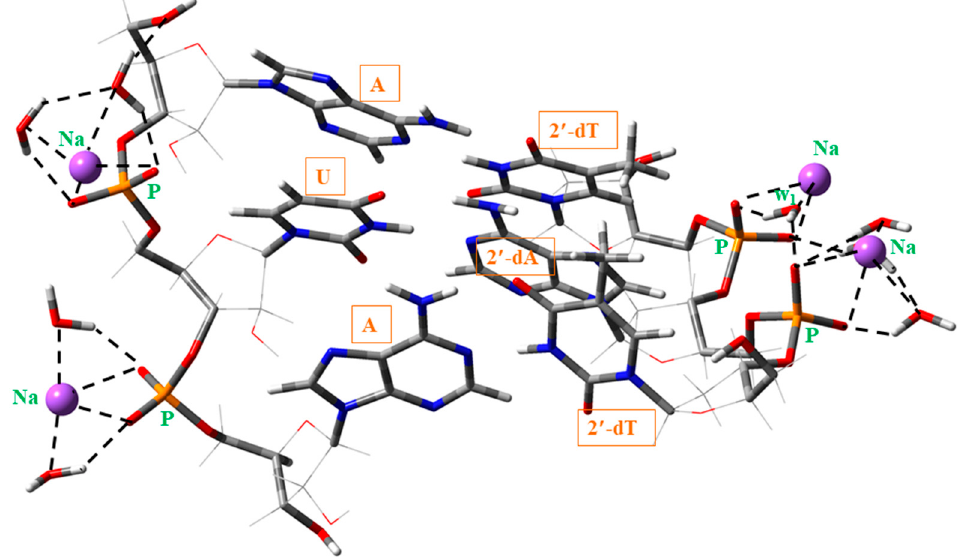
Figure 10. Microhelix 5 (cid:48) -AUA-3 (cid:48) with four sodium atoms around the phosphate group and hydrated Figure 10. Microhelix 5 ′ -AUA-3 ′ with four sodium atoms around the phosphate group and hydrated Figure 10. Microhelix 5 ′ -AUA-3 ′ with four sodium atoms around the phosphate group and hydrated Figure 10. Microhelix 5 ′ -AUA-3 ′ with four sodium atoms around the phosphate group and hydrated with 18 water molecules around these sodium atoms. with 18 water molecules around these sodium atoms. with 18 water molecules around these sodium atoms. with 18 water molecules around these sodium